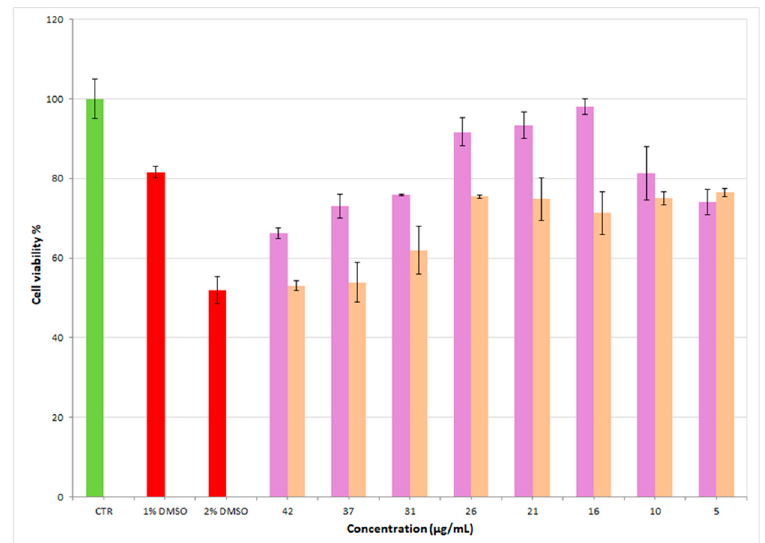
Figure 7. Effect on primary dermal fibroblasts viability incubated with different concentrations of supernatants (diluted with DMEM) deriving from the contact between MgAl-ALA (pink bars) or ZnAl-ALA (orange bars) and DMEM (n=3, ± SD). DMEM was used as negative control (CTR with 100% of cell viability) and DMSO, known to induce cell death, used as a positive control with two different concentrations.